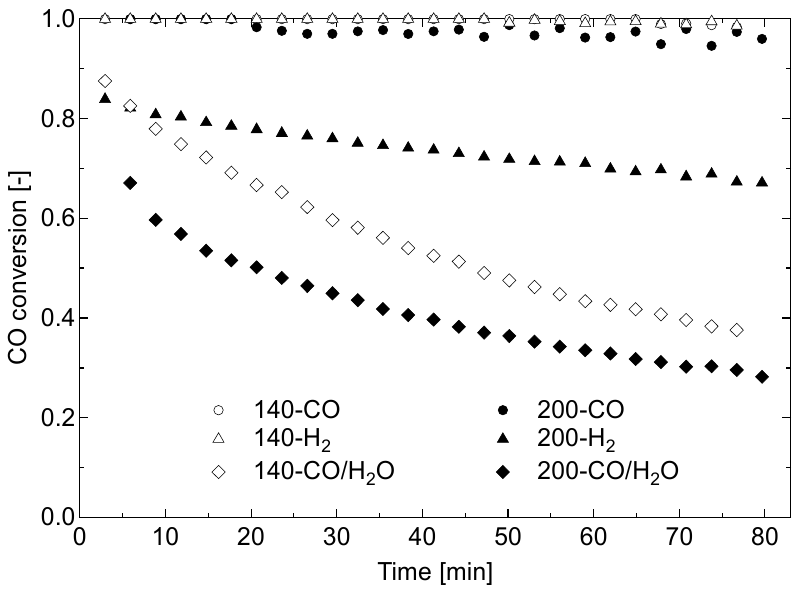
Figure 7. WGS at 80 °C using Au/Fe 30.3/67.5%, GHSV = 2800 h − 1